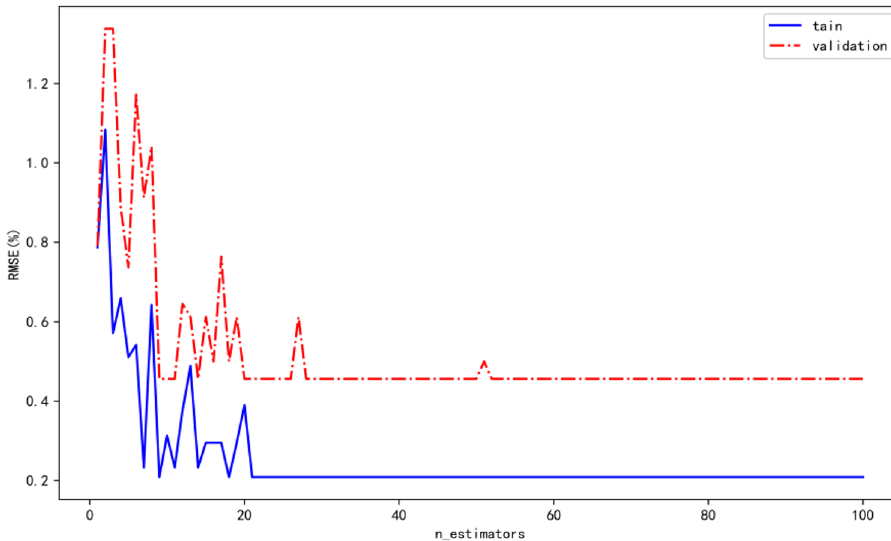
Figure 10. The RMSE curve for the increasing of n_estimator.